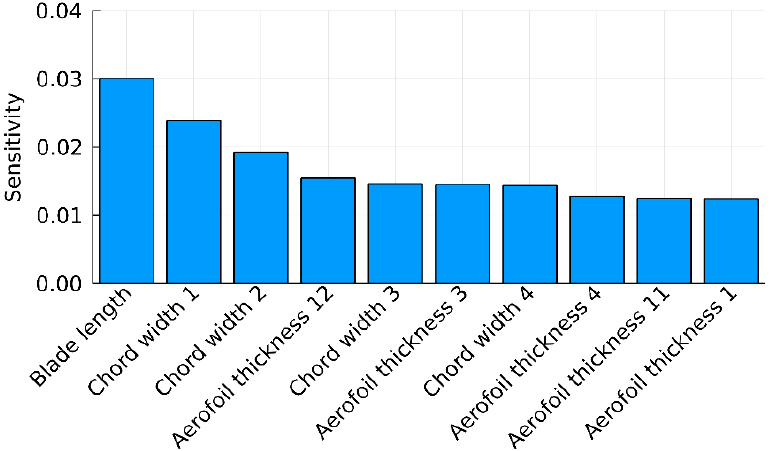
Figure 4. Sensitivity analysis results of the reference wind turbine blade geometric variables.